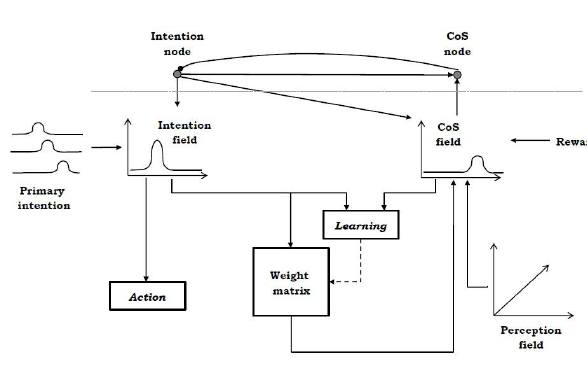
Figure 2: Architecture for CoS learning.